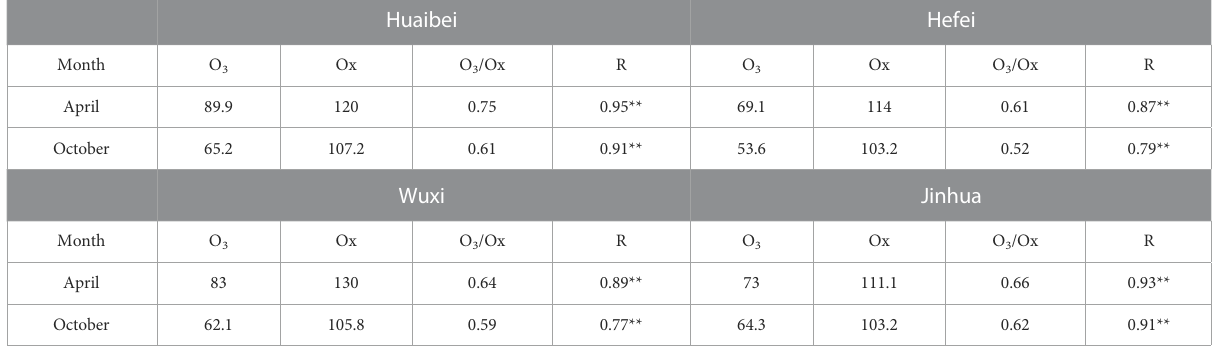
TABLE 2 O 3 , O X (O X = O 3 + NO 2 ) averages and ratios of O 3 /O X as well as correlations (R) between O X and O 3 in April and October over 2015 – 2021 in Huaibei, Hefei, Wuxi, and Jinhua.